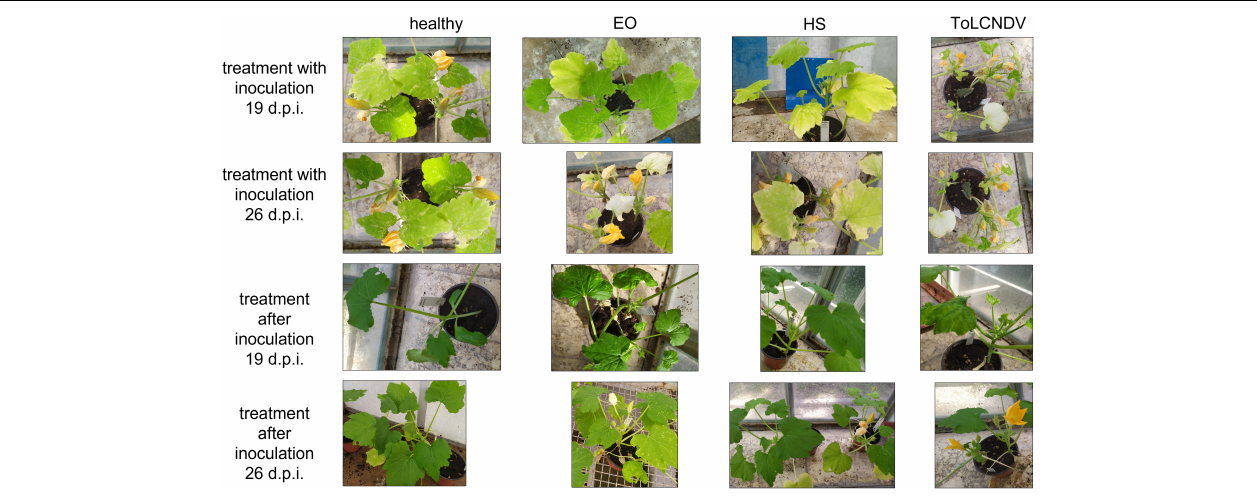
FIGURE 4 | Visual inspection of plants treated together with inoculation (upper panels) and after inoculation (lower panels) at 19 and 26 d.p.i.; the relevant healthy and infected no-treatment control is shown for each